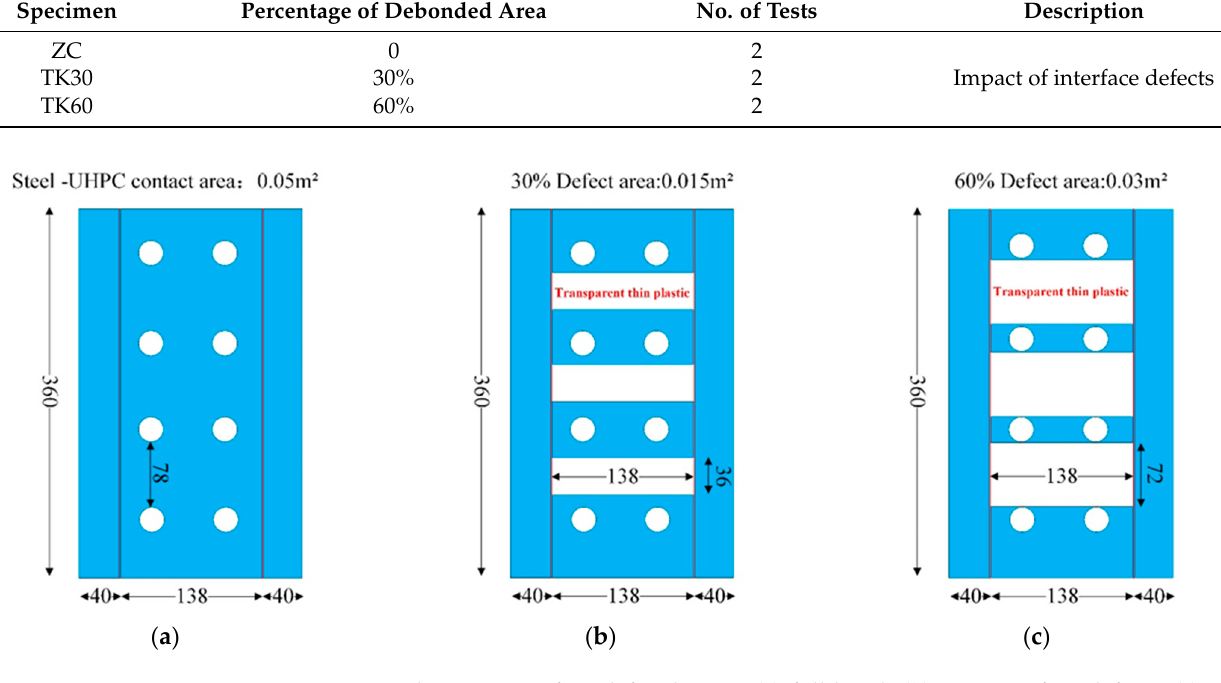
Figure 5. Steel-UHPC interface defect layout: ( a )full bond; ( b )30% interface defects; ( c )60% interface defects.